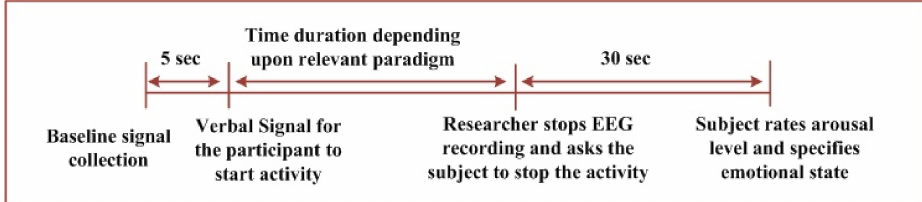
Figure 2. Block diagram of the experiment while conducting a single trial for any emotional states out of fear, joy, and neutral.